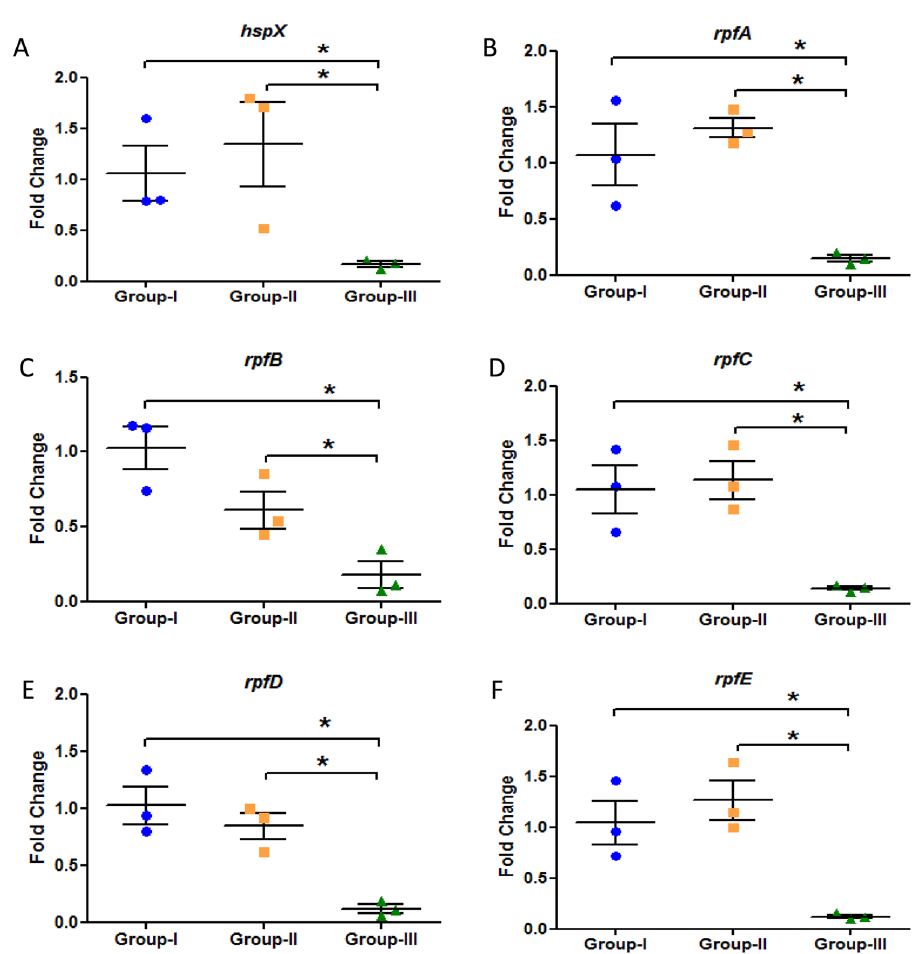
Figure 3. Expression analysis of various genes in the lungs of Group-I, Group-II and Group-III mice after 9 weeks of streptozotocin treatment. Gene expression of ( A ) hspX ( B ) rpfA ( C ) rpfB ( D ) rpfC ( E ) rpfD ( F ) rpfE . The data were represented as Mean ± SE of 3 animals in each group and the statistical significance was determined by Mann–Whitney test. *p ≤ 0.05. Group-I: latent tuberculosis only, Group-II: latent tuberculosis with diabetes and Group-III: latent tuberculosis with immunosuppression. Animal model was developed only once but gene expression was studied in triplicates from each